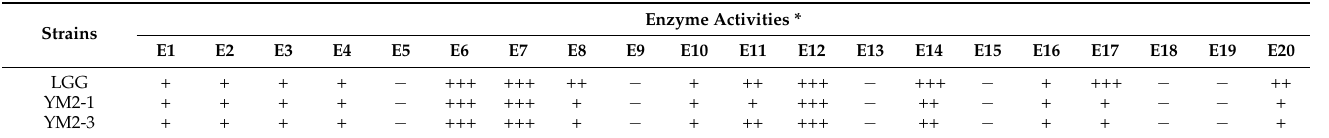
Table 4. Enzymatic activities of YM2-1 and YM2-3